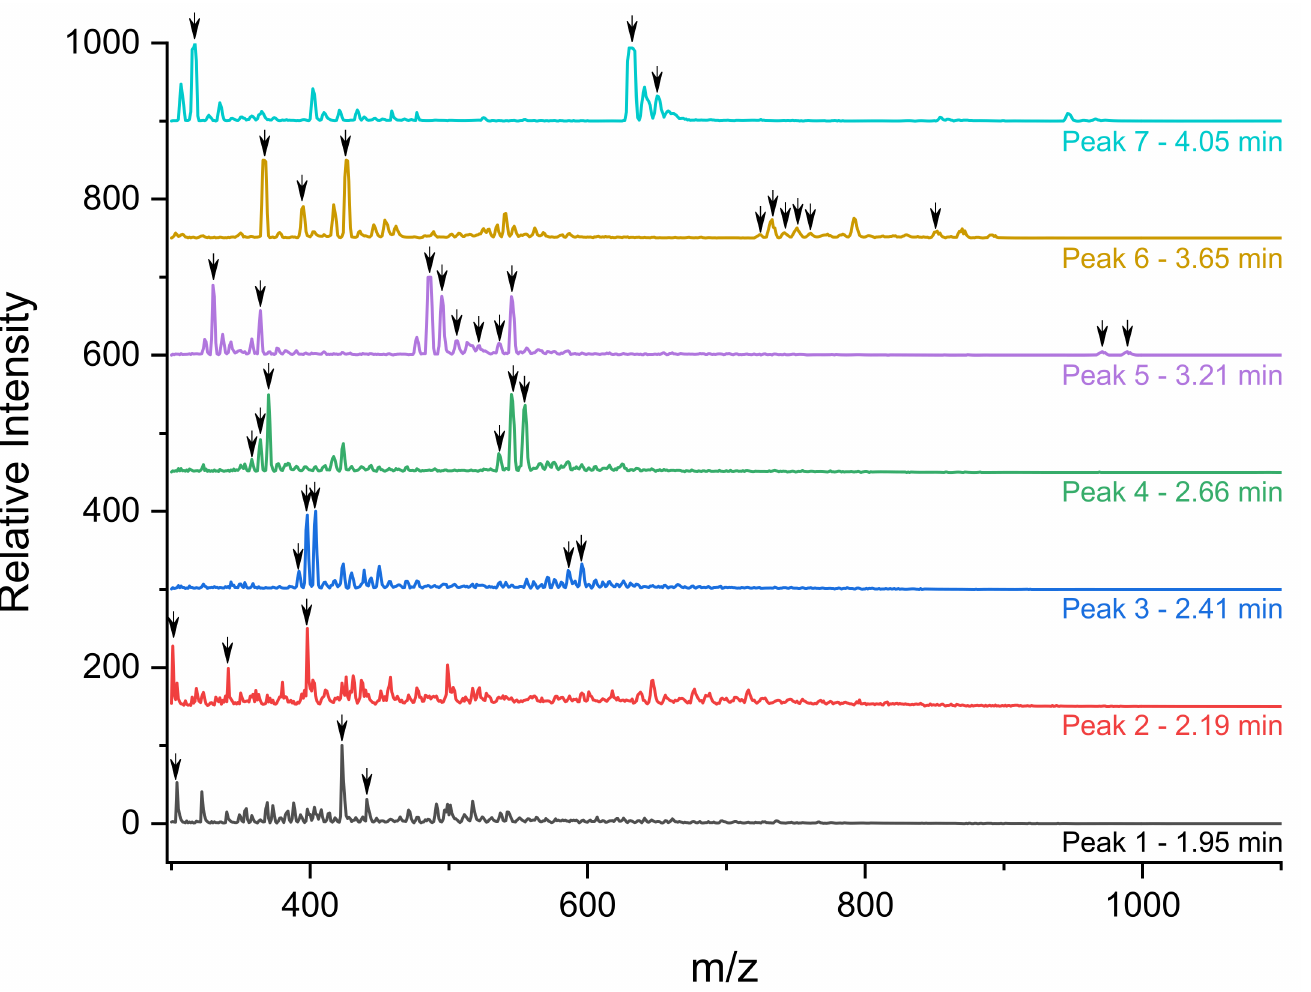
Figure 3. MS spectra of each peak identified (1–7) in the LC-ESI/MS AGuIX’s fragments chro- matogram. All identified m / z are pointed with a black